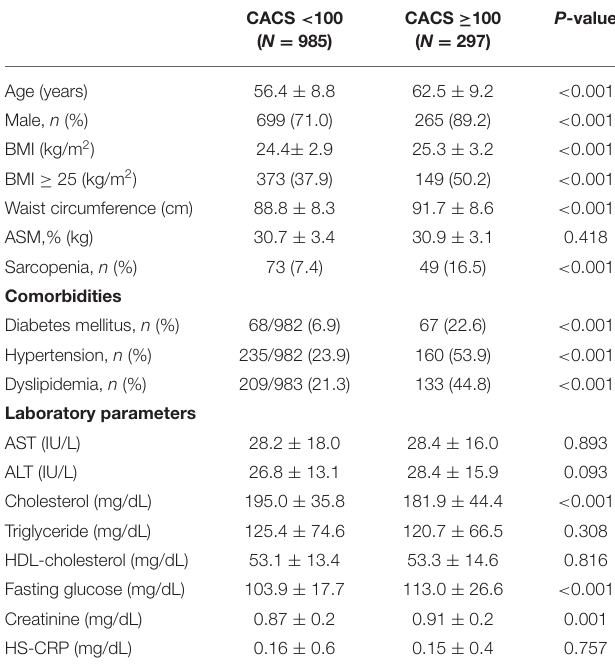
TABLE 1 | Comparison of baseline characteristics according to coronary artery calcification